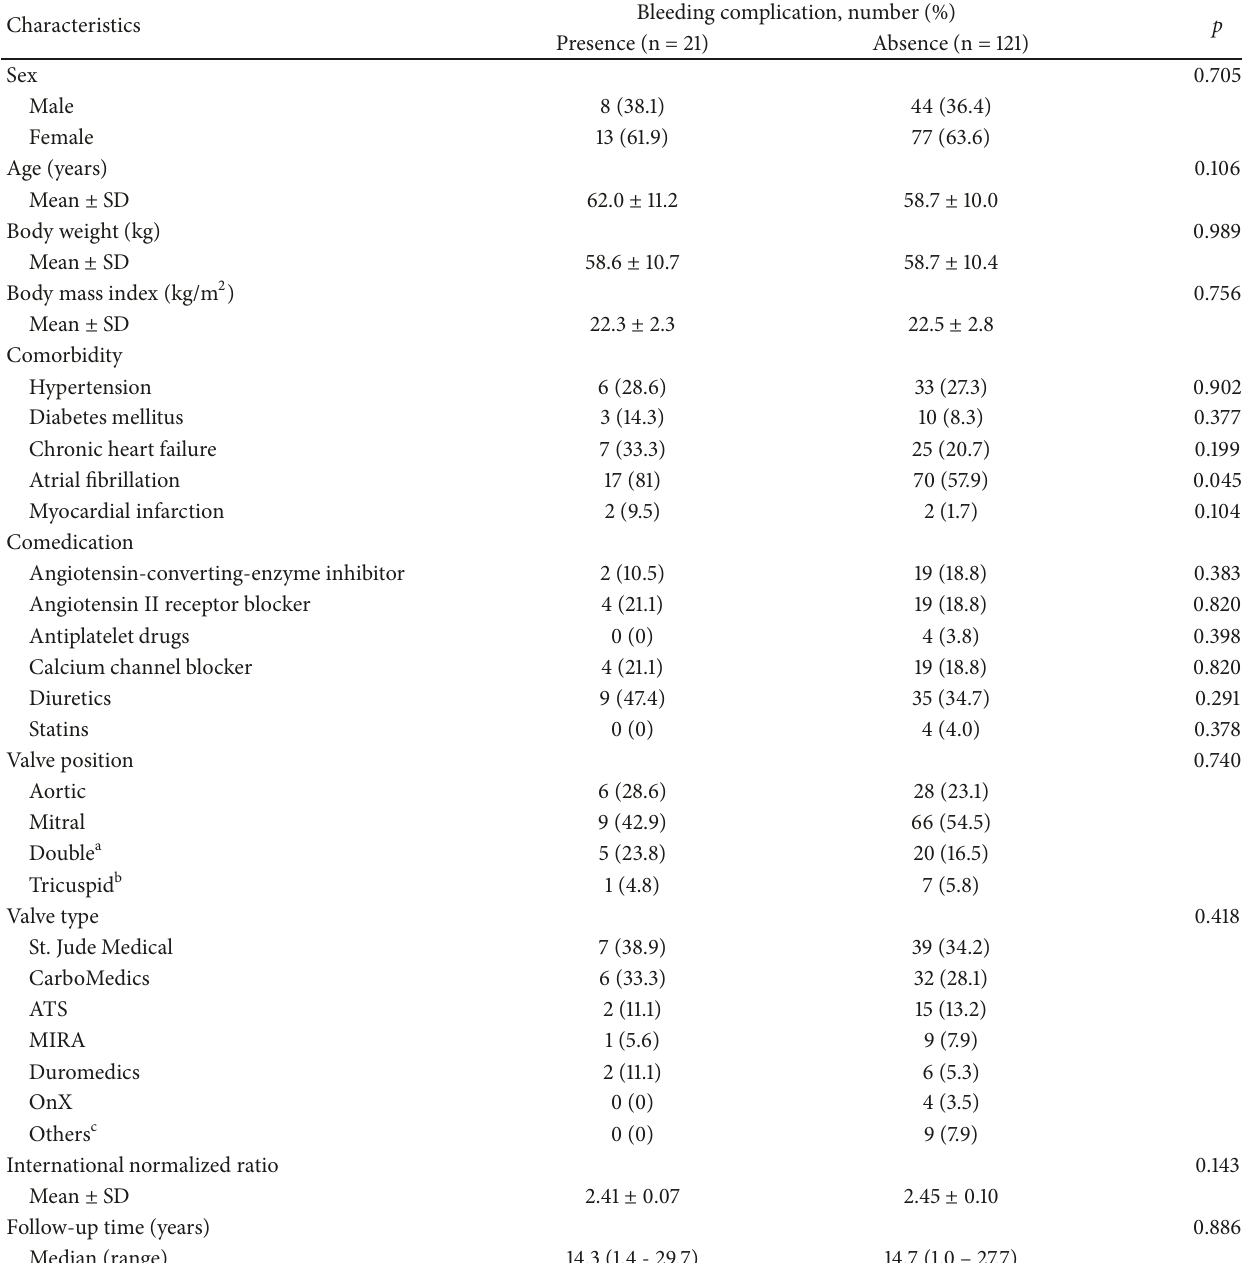
Table 1: Patient characteristics of study